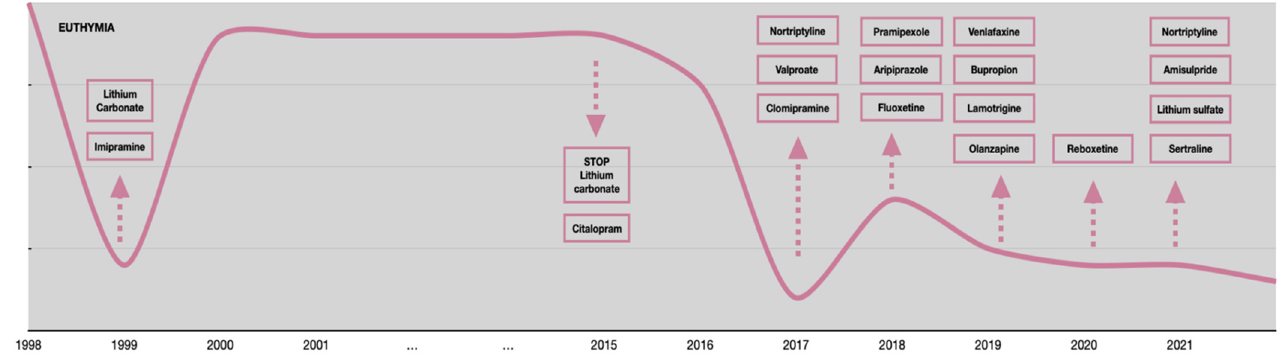
Figure 3. Mood variations from 1998 to 2021.